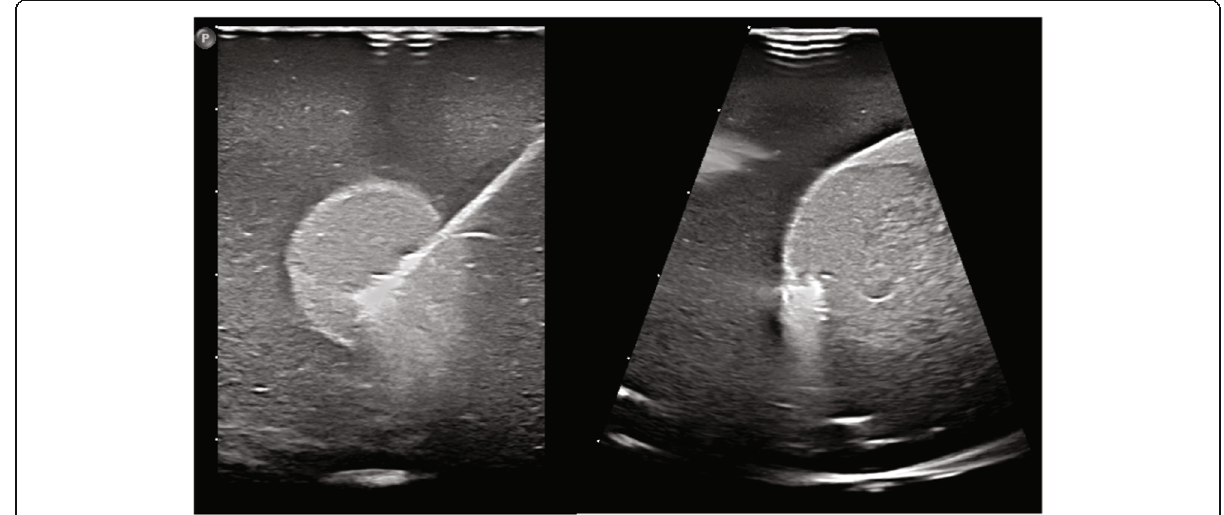
Fig. 3 Transversal (left) and sagittal (right) view of the nodule phantom during ablation with the three-dimensional (3D) matrix (real-time) transducer